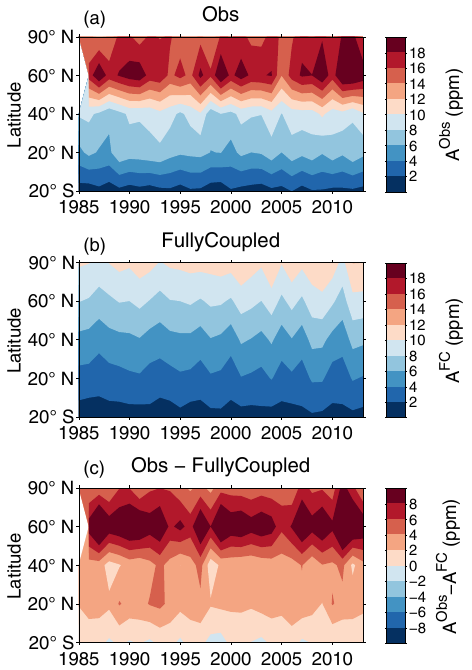
Figure 5. (a) Observed atmospheric CO 2 annual cycle amplitudes ( A Obs ), (b) FullyCoupled atmospheric CO 2 annual cycle ampli- tudes ( A FC ), and (c) the difference between A Obs and A FC during